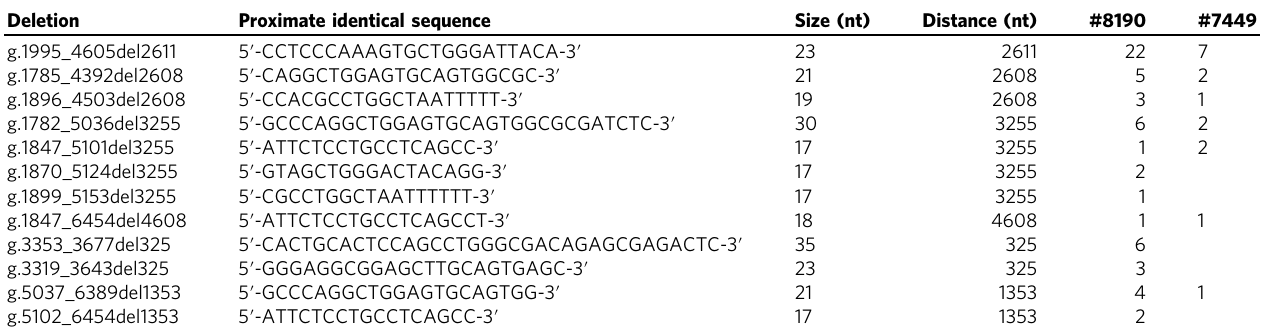
Table 1 Summary of large deletions in the genome edited G1H/Cas9 mice.